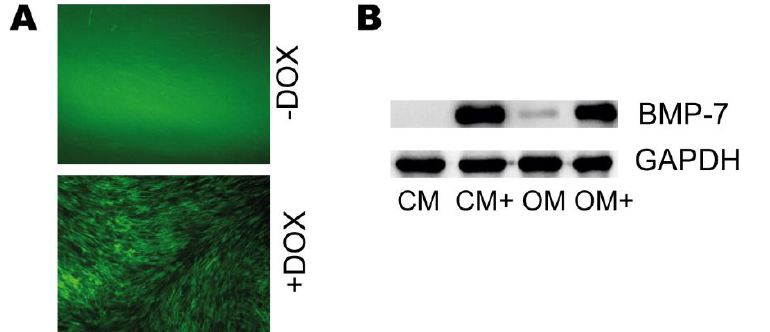
Figure 1. ( A ) Representative images of the DPSC-BMP-7 cell line incubated in the presence (DOX) or absence ( − DOX) of doxycycline. ( B ) Western blot analysis of DPSC-BMP7 cell lysates.